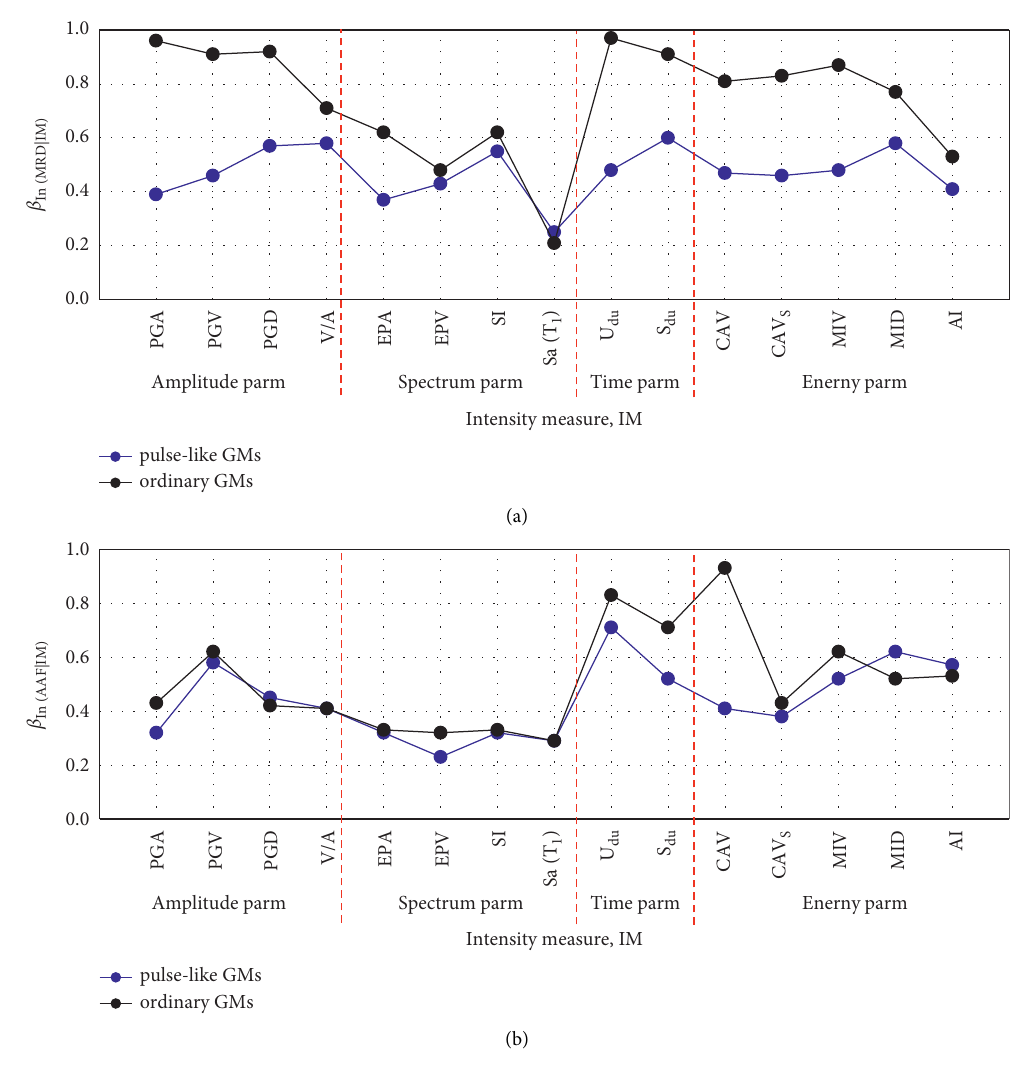
Figure 4: Reveals the following: (a) MRD and (b) AAF, obtained from the cloud analysis subjected to pulse-like and ordinary ground motions.